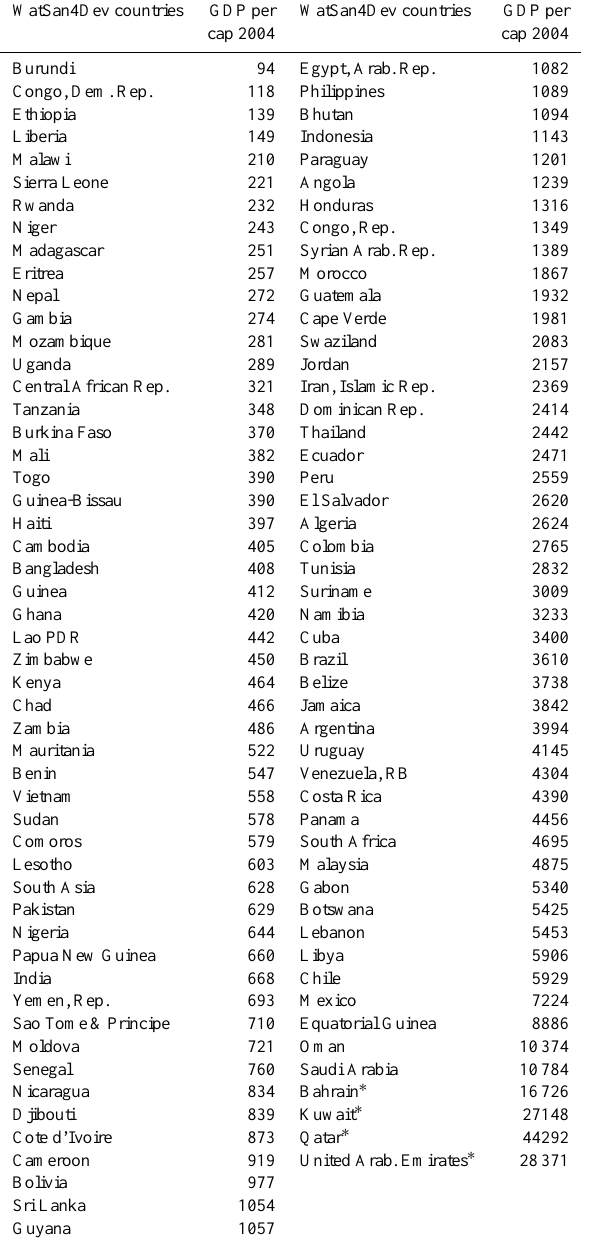
Table 2. Countries included in the WatSan4Dev